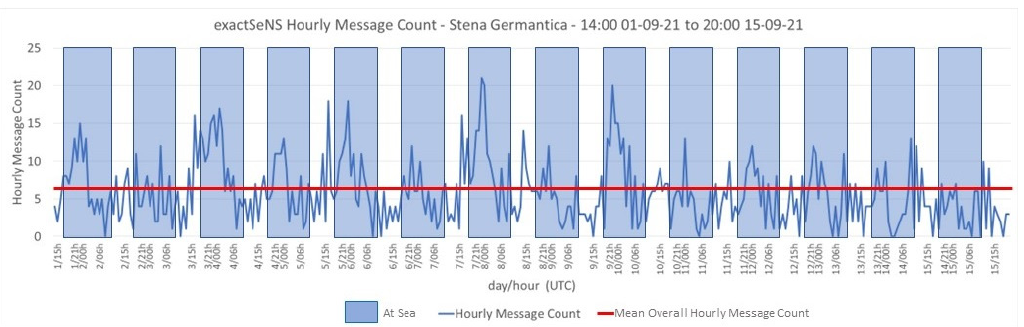
Figure 12. exactSeNS detected hourly message count—Stena Germanica trial 1–15 September 2021.